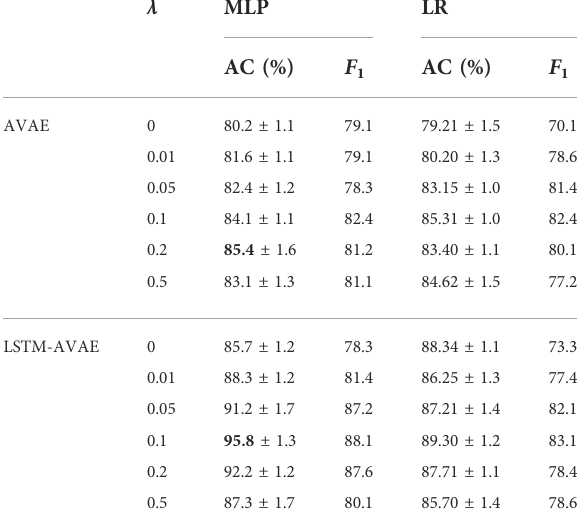
TABLE 2 Comparing the impact of the adversary network on the model accuracy (MLP: multilayer perceptron, LR: linear